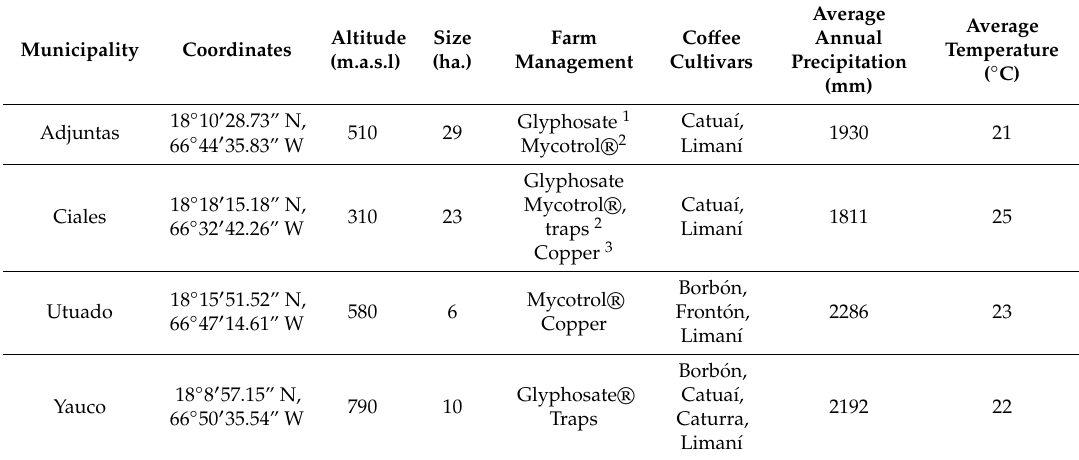
Table 1. Characteristics of coffee farms sampled. Weather data from xmACIS (http: // xmacis.rcc-acis.org / ).